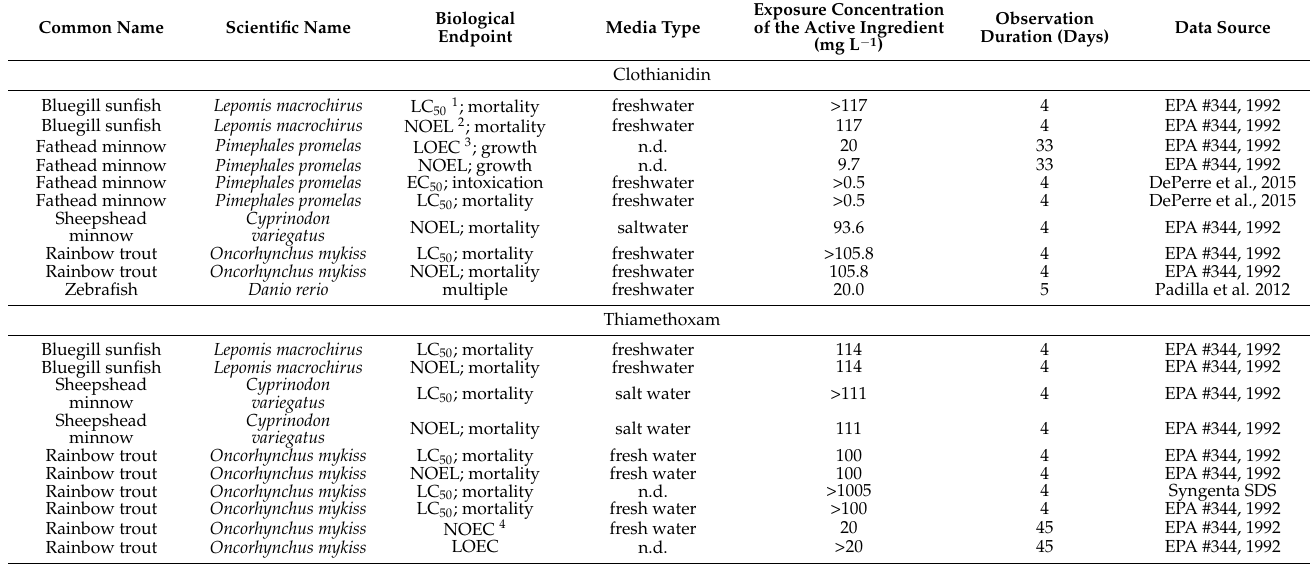
Table 1. Compilation of results on fish organismal response after exposure to clothianidin or